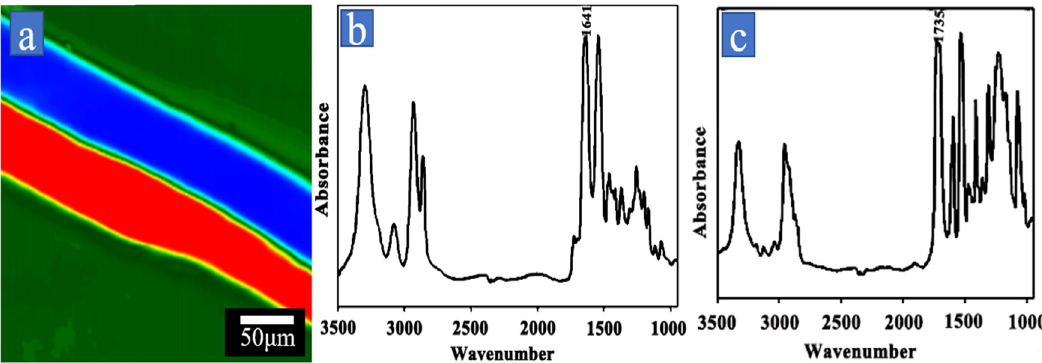
Figure 10: ( a ) Infrared chemical image of polyurethane/nylon bicomponent fi ber formed by imaging at 1,641 and 1,735 cm − 1 , ( b ) infrared spectrum of the red part, identi fi ed as nylon, and ( c ) infrared spectrum of the blue part, identi fi ed as polyurethane. ( a – c ) Adapted with permission ( 129 ) Copyright 2006, American Academic of Forensic